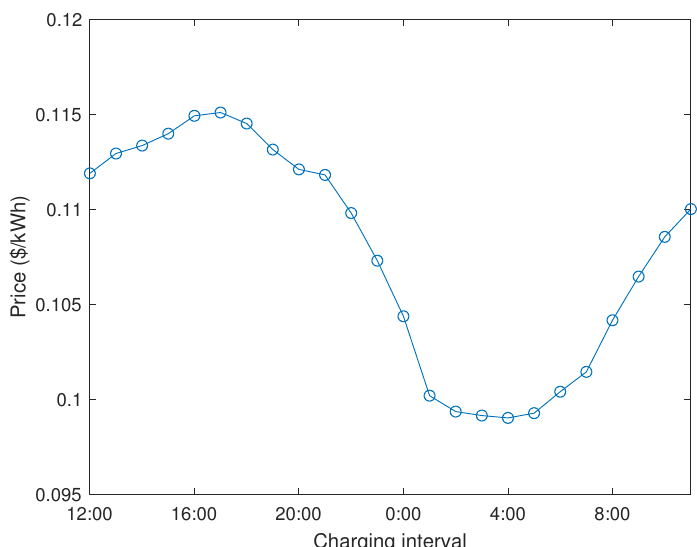
Figure 6. Edge weights update for Algorithm 3 under replay attack.